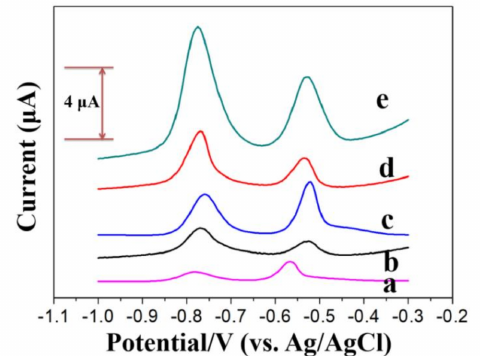
Figure 6. The square-wave anodic stripping voltammetry (SWASV) curves of 40 µ g / L of Pb(II) and Cd(II) with bare GCE ( a ), rGO / GCE ( b ), Nafion / GCE ( c ), (BiO) 2 CO 3 -rGO / GCE ( d ), and (BiO) 2 CO 3 -rGO-Nafion / GCE ( e